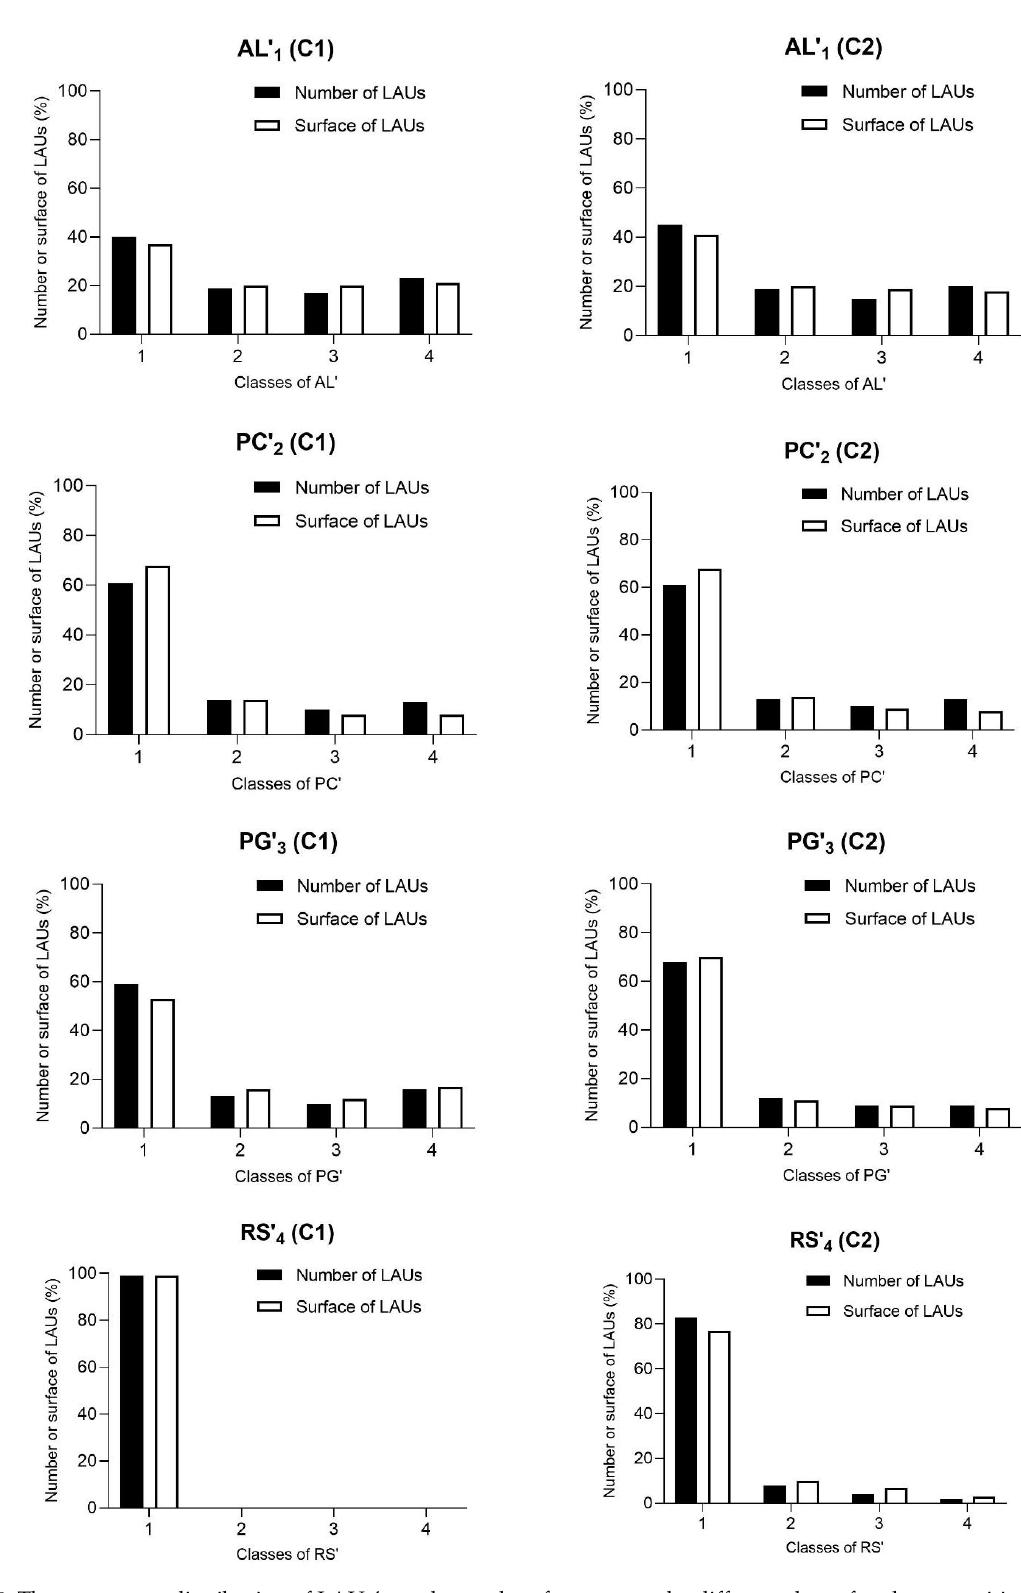
Figure 5. The percentage distribution of LAUs’ number and surface among the different class of each composition indicator